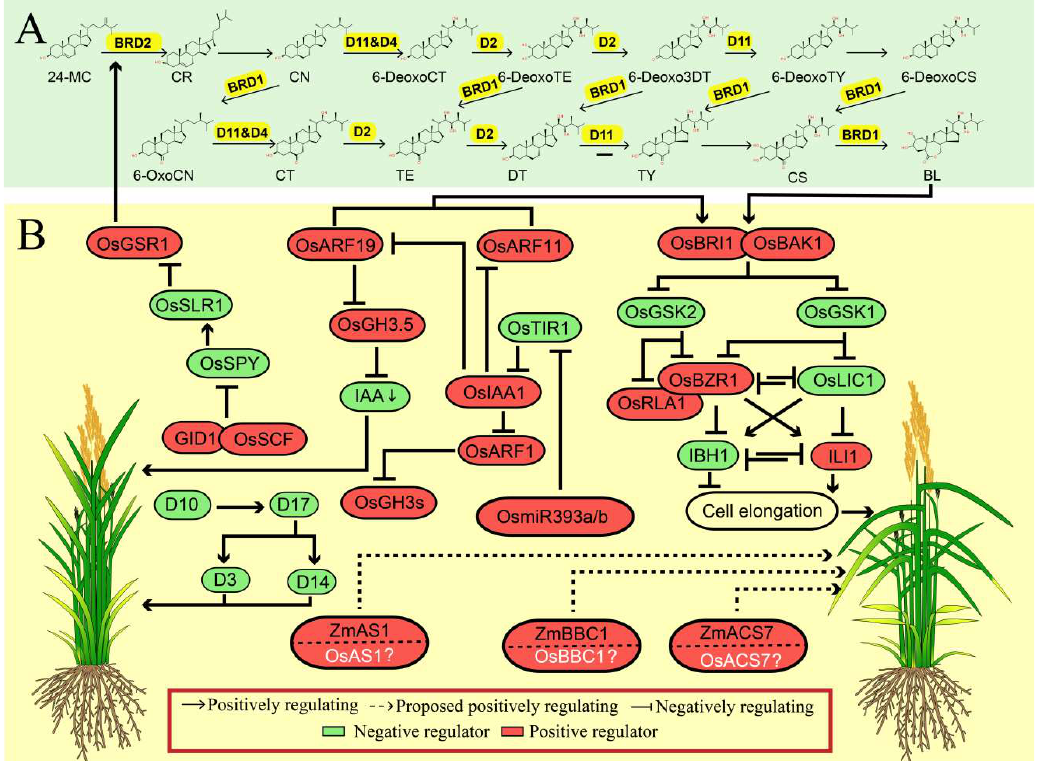
Figure 2. The synergistic regulation mechanisms of leaf angle by phytohormones in rice. ( A ) Brassinosteroid biosynthesis pathway. The corresponding enzyme that catalyze each reaction in yellow color. The secondary structure of the chemical is obtained from ChemSpider (http://www.chemspider.com/Default.aspx). ( B ) Positive and negative regulation of leaf angle by brassinosteroid (BR) signaling pathway and its crosstalk with other regulators involved in other plant hormones pathway, and other phytohormones regulators positively participate in regulation of leaf angle. The proteins in white color and with a question mark represent that they are homologs of those reported to be involved in the regulation of leaf angle. The green arrow represents the downregulation of indoleacetic acid (IAA). The protein in red color box represents as the positive regulator while the one in green color box represents the negative regulator of leaf angle. The dashed line and solid line represent the indirect or direct evidence supporting the responsible regulation, respectively.